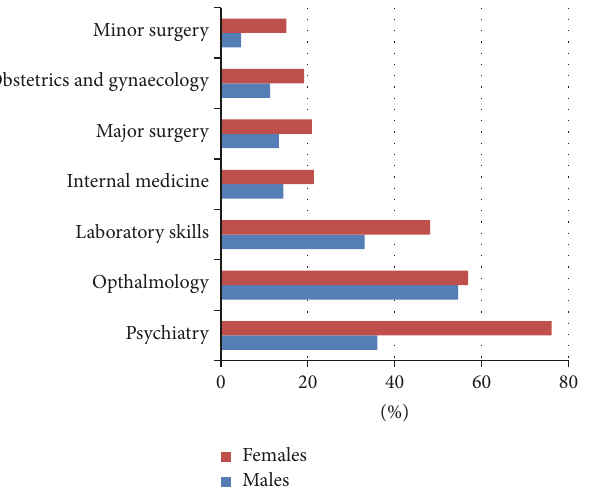
Figure 1: Gender variation in relative competency change in clinical disciplines among master’s programme candidates of GFMP, Gezira state, Sudan ( 𝑁 = 108 , 46 males and 62